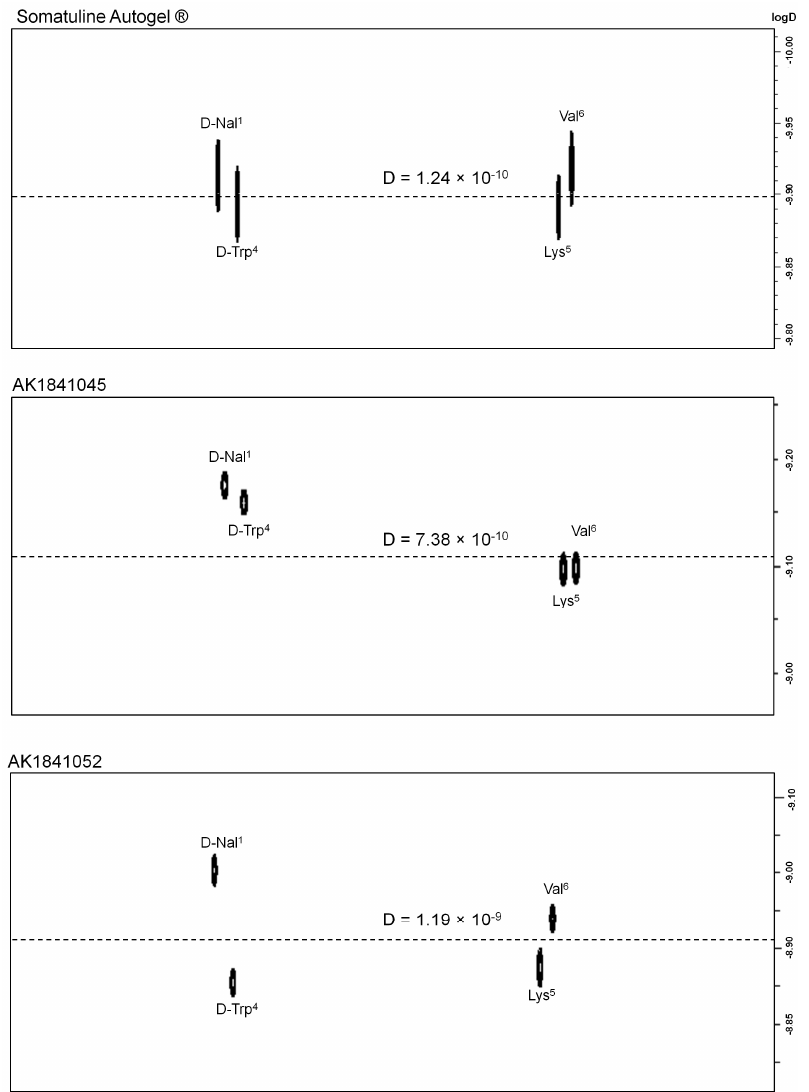
Figure 3. The 2D-DOSY experiments acquired at 300 K on a 500 MHz spectrometer equipped with HR-MAS probe. Spectra reporting the distinctive peaks of Somatuline Autogel ® , AK1841045 (11% of AcOH), and AK1841052 (5.7% of AcOH), obtained in DMSO-d 6 . The diffusion values were calculated as an average of each peptide peak diffusion value (m 2 /s) and were reported as D values (on the dashed lines) and as logD (ordinate on the right).